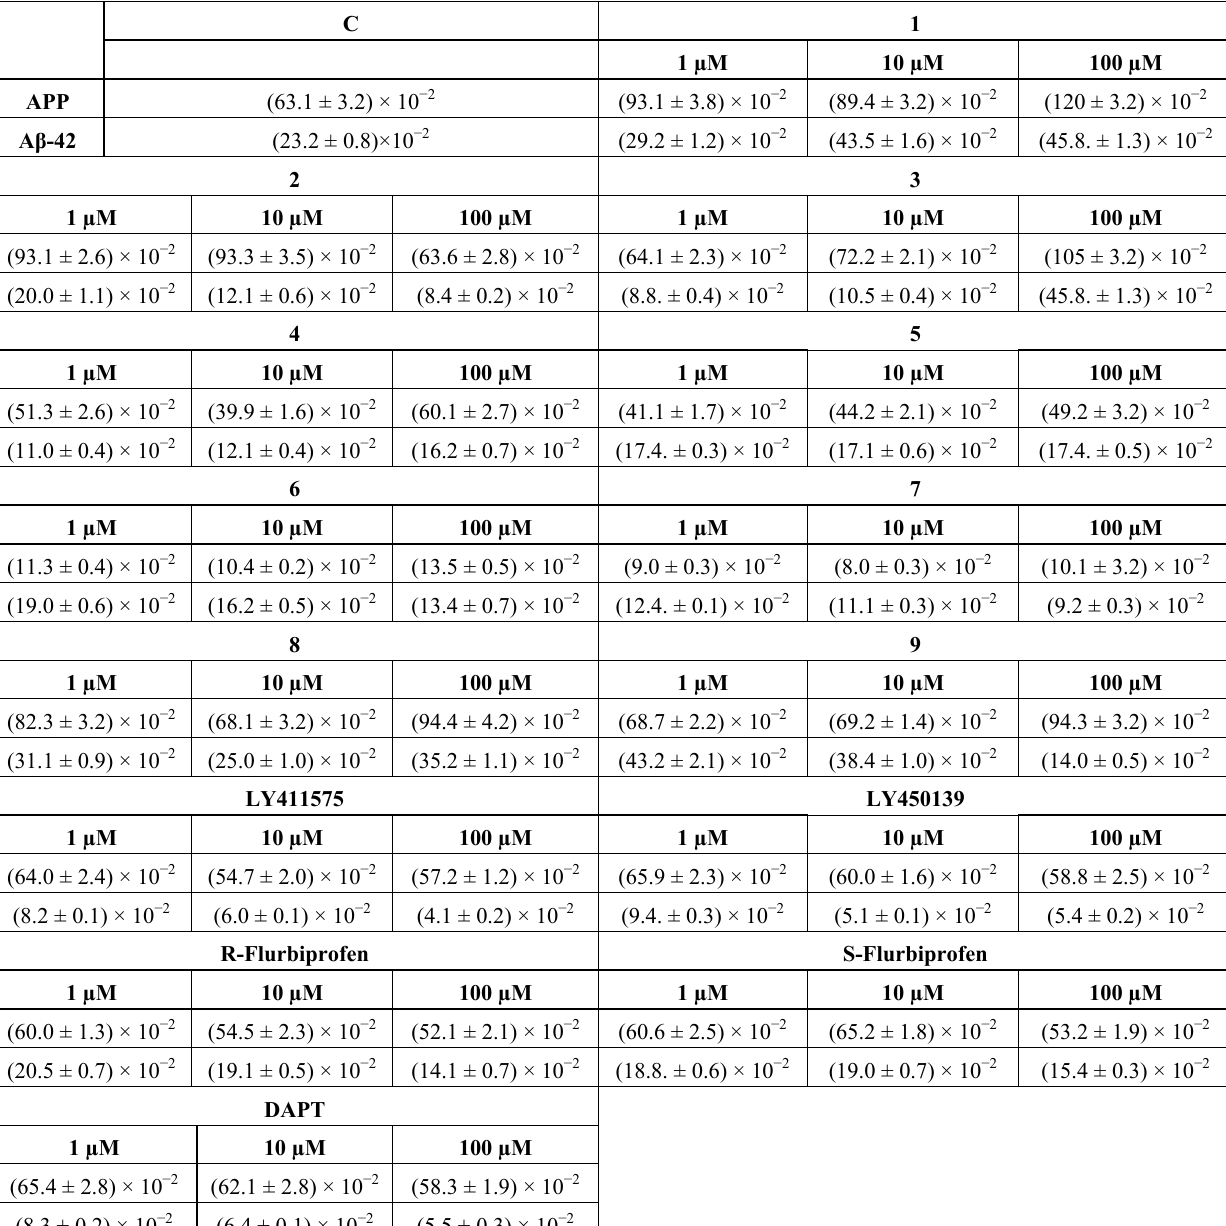
Table 4. Expression of APP and A β -42 in CTXNA2 astrocytes exposed to different concentrations of the investigated 1 – 9 derivatives for 24 h (the most representative out of three different consistent experiments). Samples have been normalized by incubating membranes in the presence of β tubulin monoclonal antibody. Western blotting is the most representative out of three different consistent